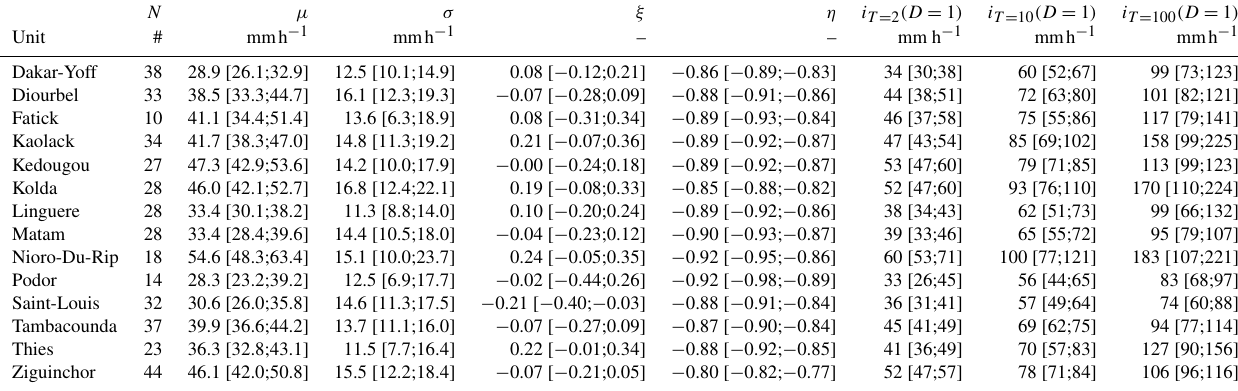
Table 2. IDF SiSca fitted parameter values and 90% confidence interval estimated by bootstrap (in brackets).